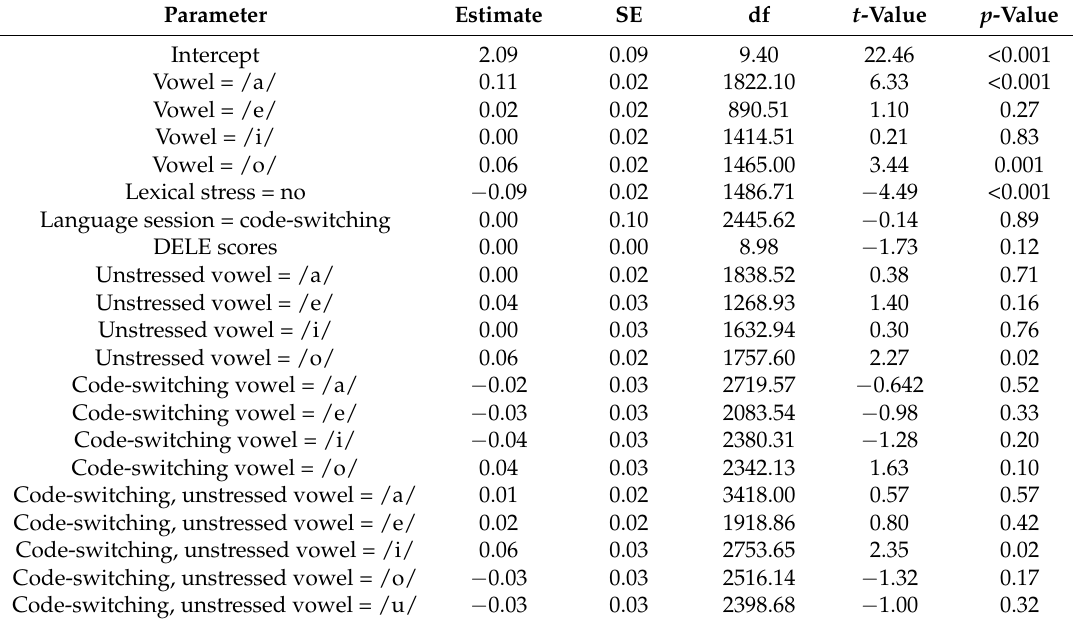
Table 7. Results from the linear mixed effects model for vowel